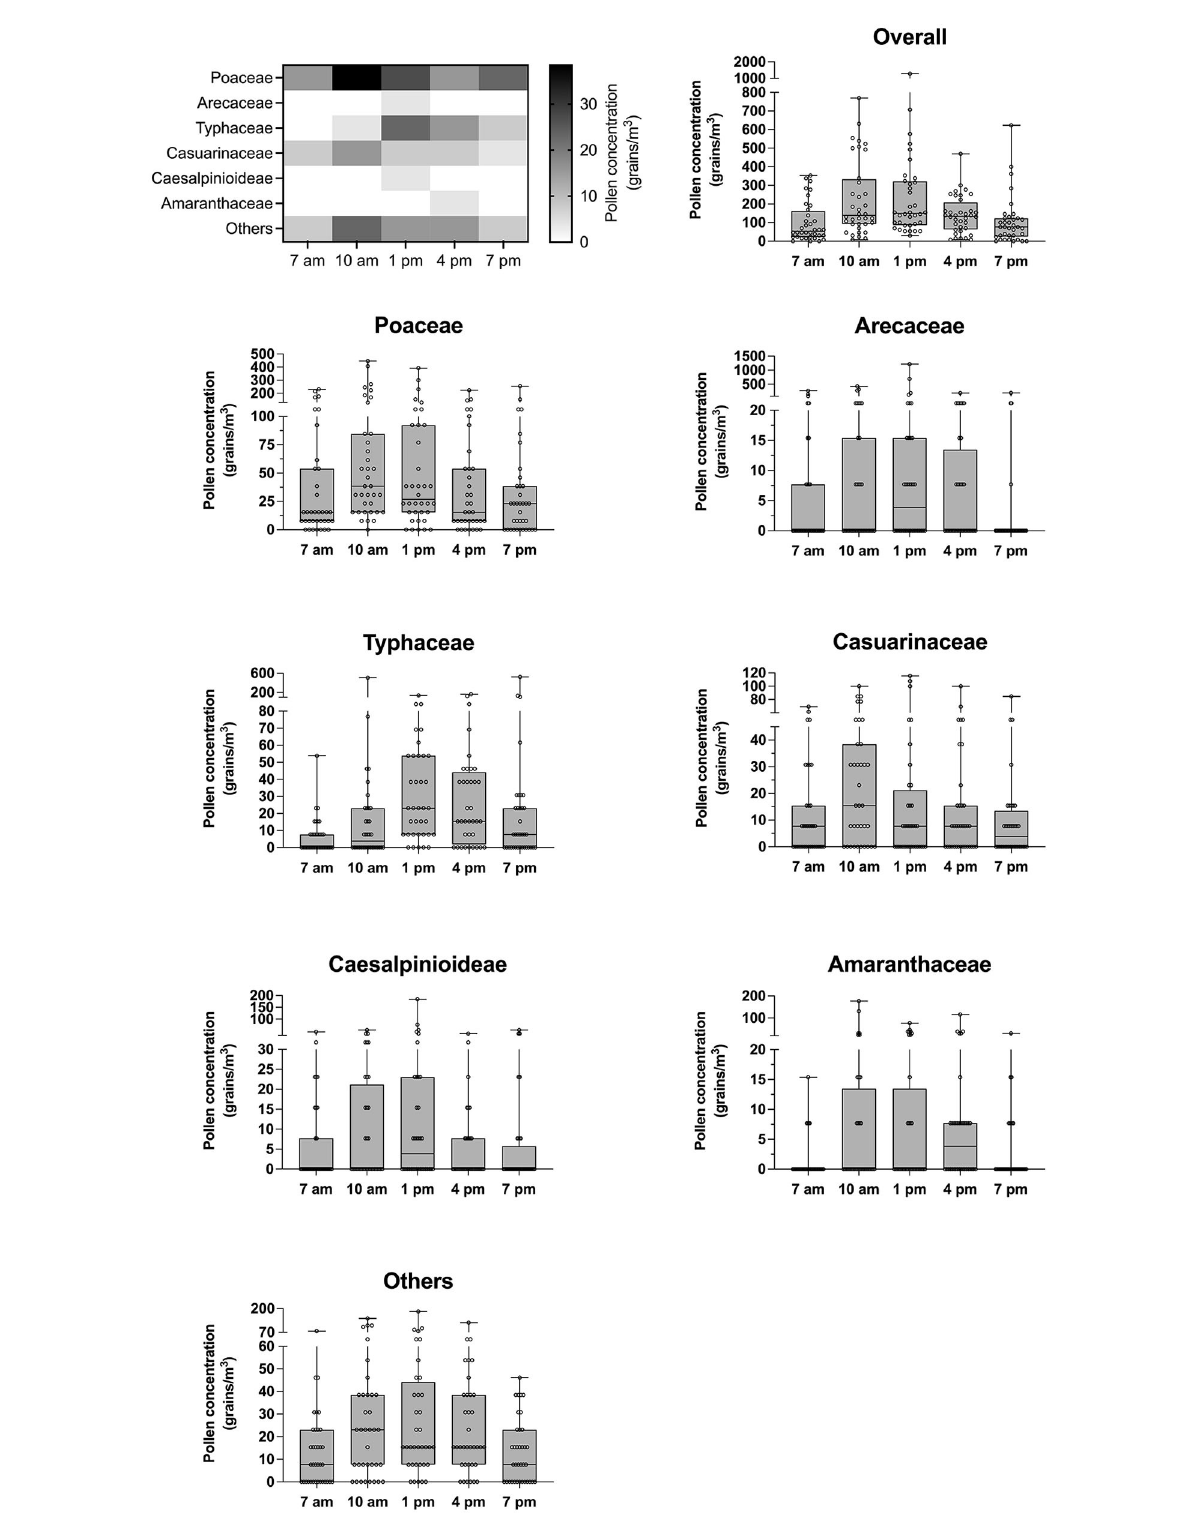
FIGURE2 Deviations of pollen count influenced by diurnal cycle. Heat map generated based on the median of each pollen species illustrates airborne pollen fluctuation at each diurnal cycle. Error bars of box plots represent median and interquartile